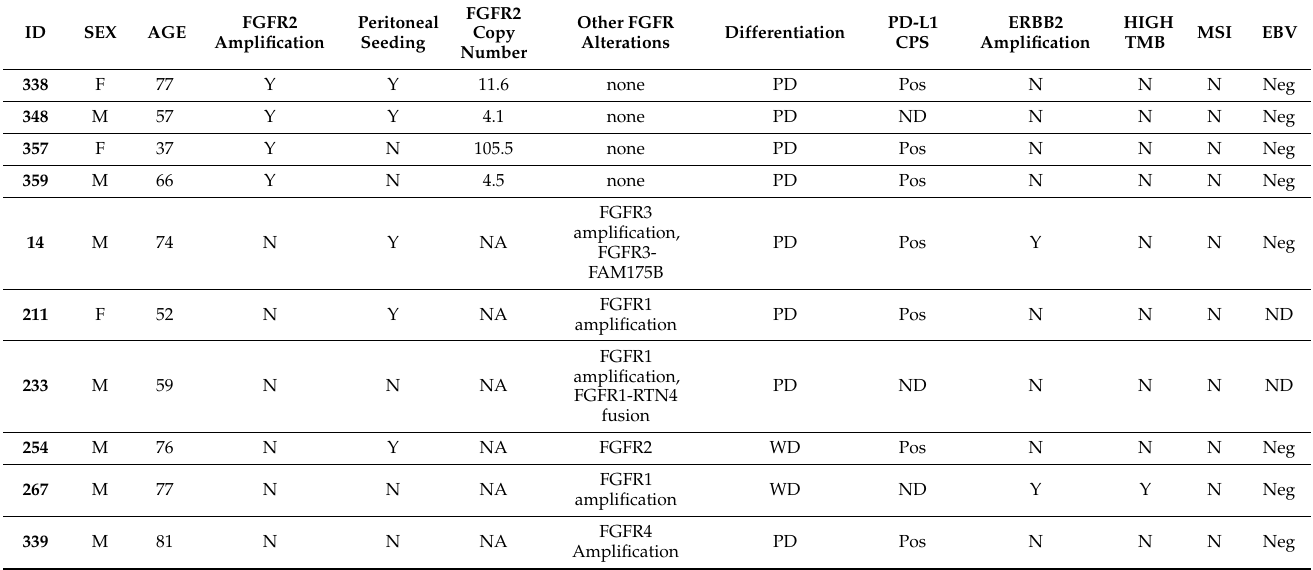
FGFR: fibroblast growth factor receptor; ERBB2: Erb-B2 receptor tyrosine kinase 2; TMB: tumor mutational burden; MSI: microsatellite instability; EBV: Epstein–Barr Virus; PD-L1: programmed death-ligand 1; CPS: combined positive score; F: female; M: male; Y: yes, N: no; NA: not applicable; PD: poorly differentiated; MD: moderately differentiated; WD: well-differentiated; Neg: negative; Pos: positive; ND: not done. Of the 185 patients without peritoneal seeding, 56 (30.3%) were female, while in